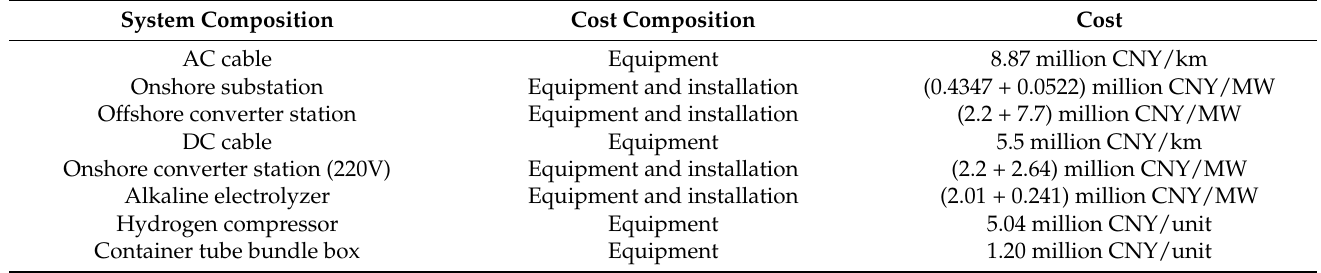
Table 1. Economic parameters of an offshore wind power hydrogen production system.